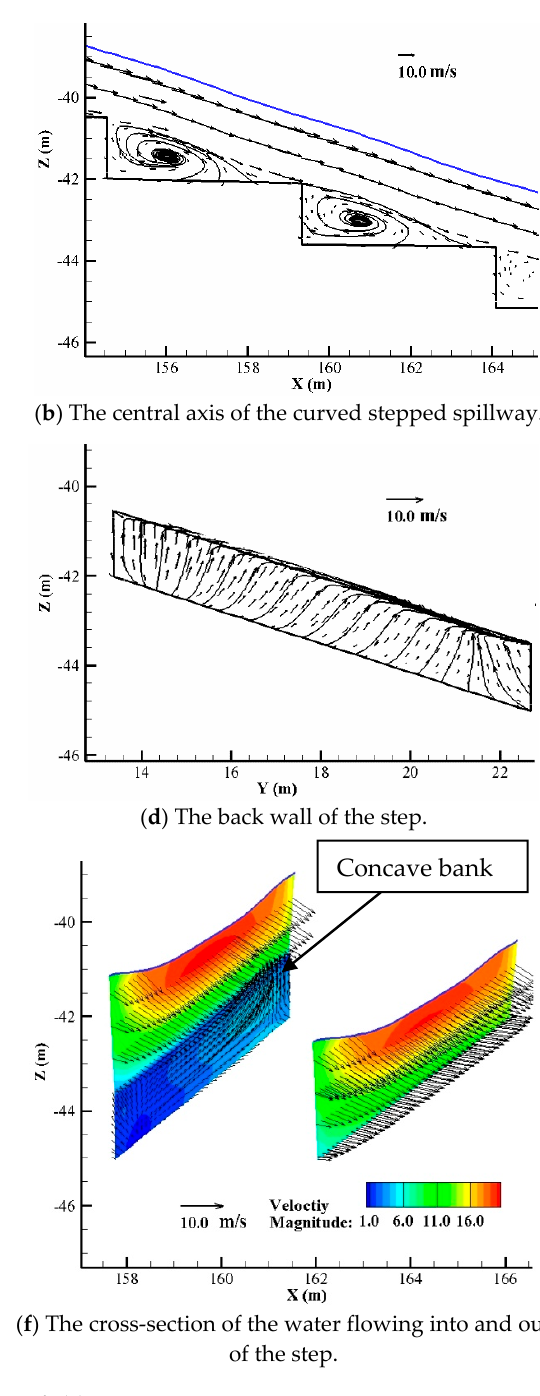
Figure 15. The velocity field at step No. 17.